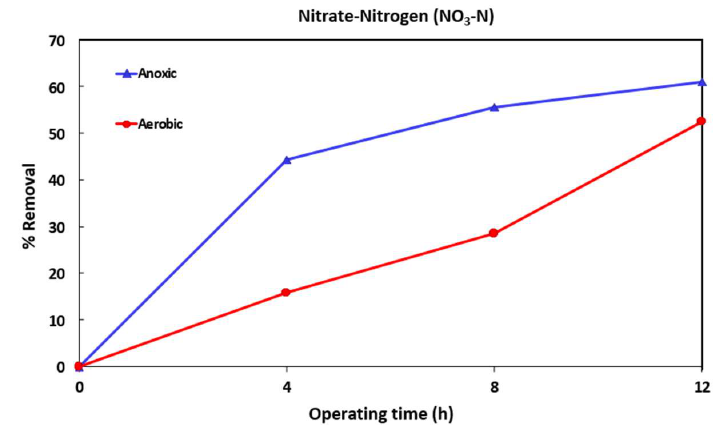
Figure 3. Parentage TAN removal during 12 h MBR operation. TSS in the anoxic and aerobic tanks was about 5100 and 6500 mg/L respectively.